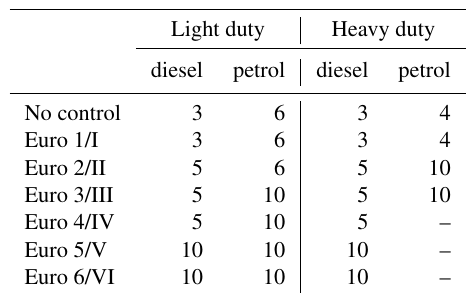
Table 6. Particulate matter amplification factors for high-emitting light- and heavy-duty diesel and petrol vehicles used in the GAINS